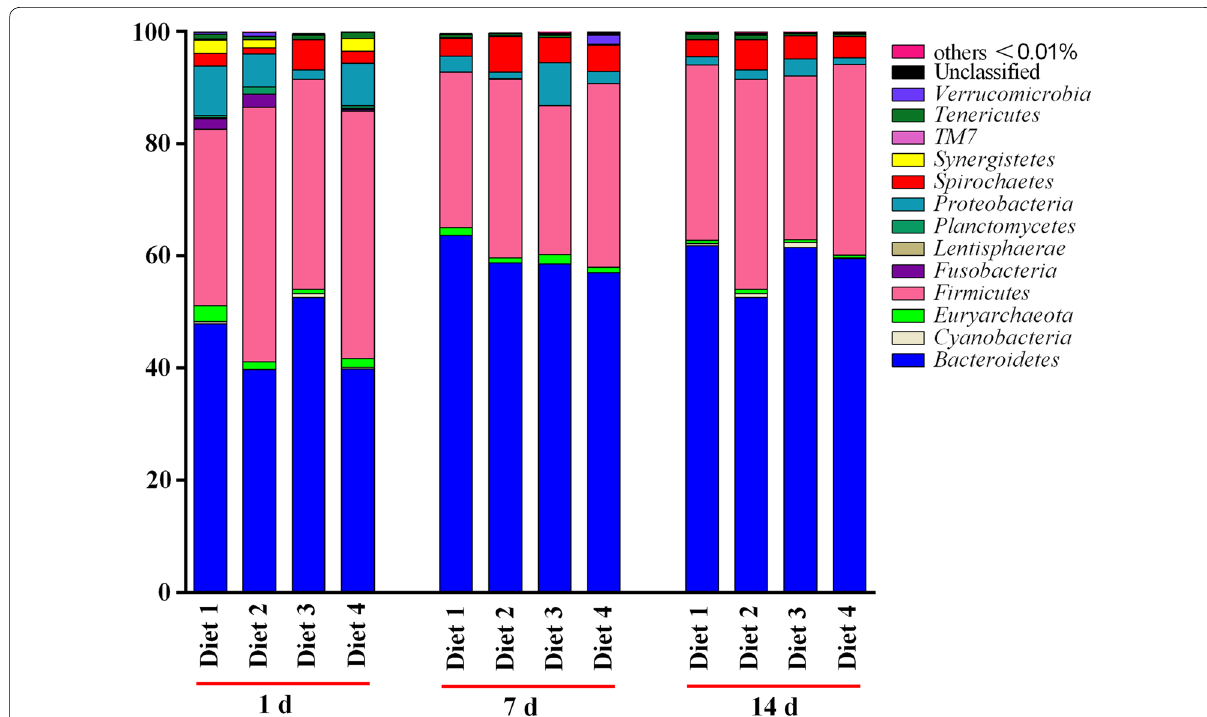
Fig. 4 Distribution of bacterial community structure at phylum level in different phases. The relative abundances lower than 0.01% are not shown. 1 day, 7 days, and 14 days represent experimental day 1, 7, and 14, respectively. The relative abundance at phylum level was statistically analyzed through non-parametric Kruskal–Wallis